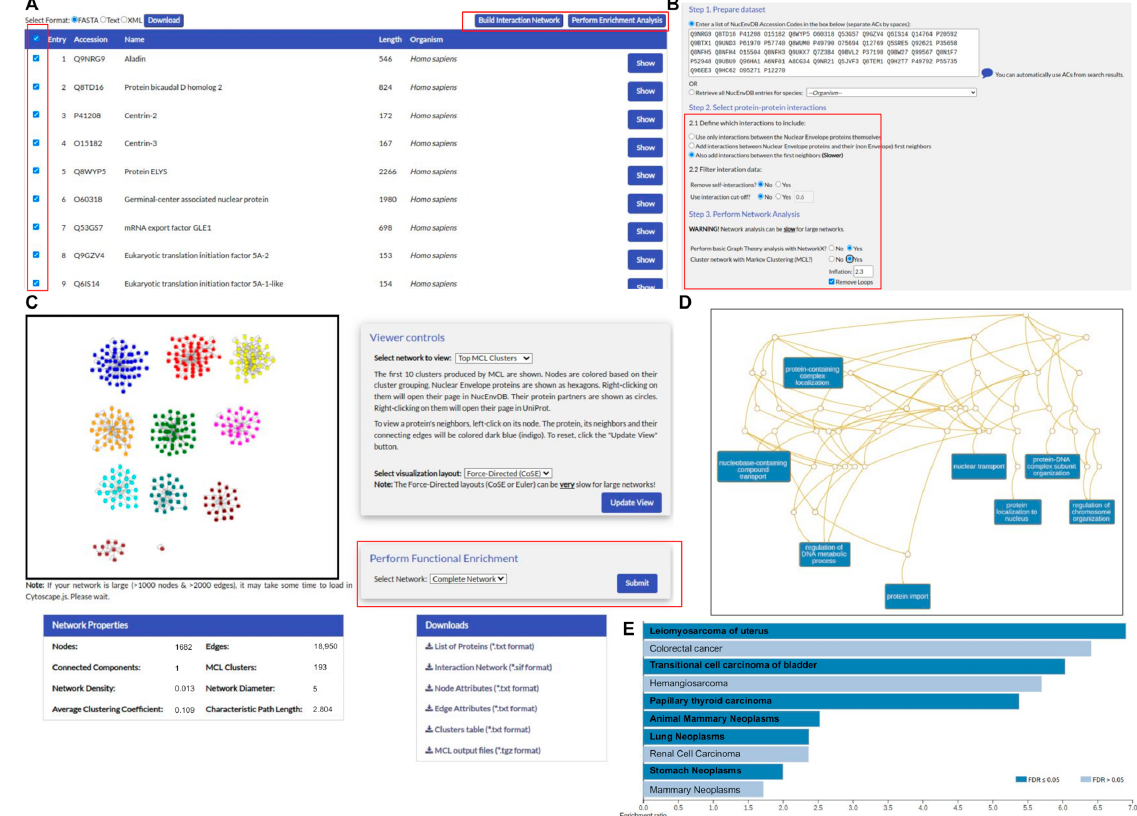
Figure 3. Example of PPI network analysis using the tools offered by NucEnvDB. ( A ) Through the Protein Browser, users may select one or more entries by clicking on the checkboxes to the left of the table. Selected entries can be downloaded using the buttons on the left, or sent for network analysis or functional enrichment using the buttons on the right. ( B ) Input form for the Network Analysis tool. Users can type/paste a list of NucEnvDB proteins (accession codes) into the input form, or select the NucEnvDB contents of an organism from the dropdown list. If the selection process described in ( A ) is followed, the input form is pre-loaded using the selected NucEnvDB entries. Users can select the type of interactions to include in the network from three options (only NE proteins, NE proteins, and first neighbors or full interactions, including the PPIs among first neighbors). They can also filter to exclude self-interactions or limit contacts to a specific confidence score (Mi-score) cutoff. Finally, they can choose to perform topological analysis or cluster their network with MCL. ( C ) The results panel, including a network viewer. Visualization can be performed for the entire network or for the top 10 MCL clusters, using a number of different layout algorithms. The topological properties of the network are given below the network viewer. The network and its components can be downloaded in formats compatible with Cytoscape from the Downloads panel, or sent for functional enrichment. ( D ) Functional enrichment with GO terms for the network components. Enriched GO categories are presented in the form of a directed acyclic graph. ( E ) Functional enrichment with disease associations for the network components. Results are given in a bar chart, with statistically significant terms colored deep